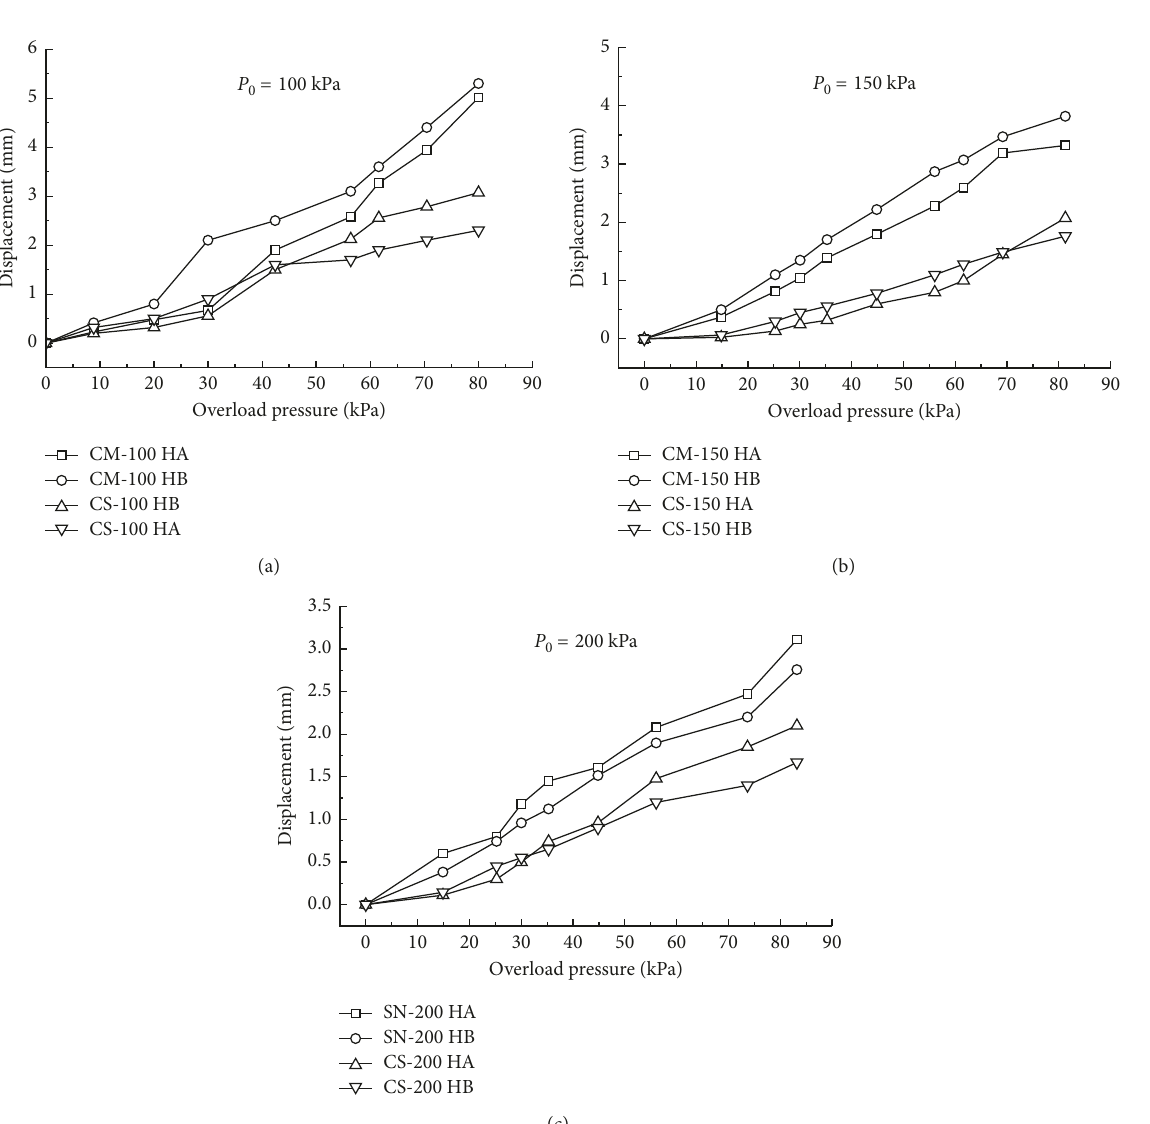
� 100 kPa, (b) initial pressure 0